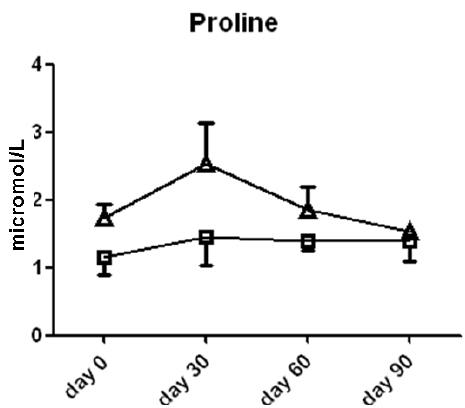
Figure 6. Proline content in serum from subjects treated with L -arginine (triangles) or placebo (squares). Data are presented as mean ±